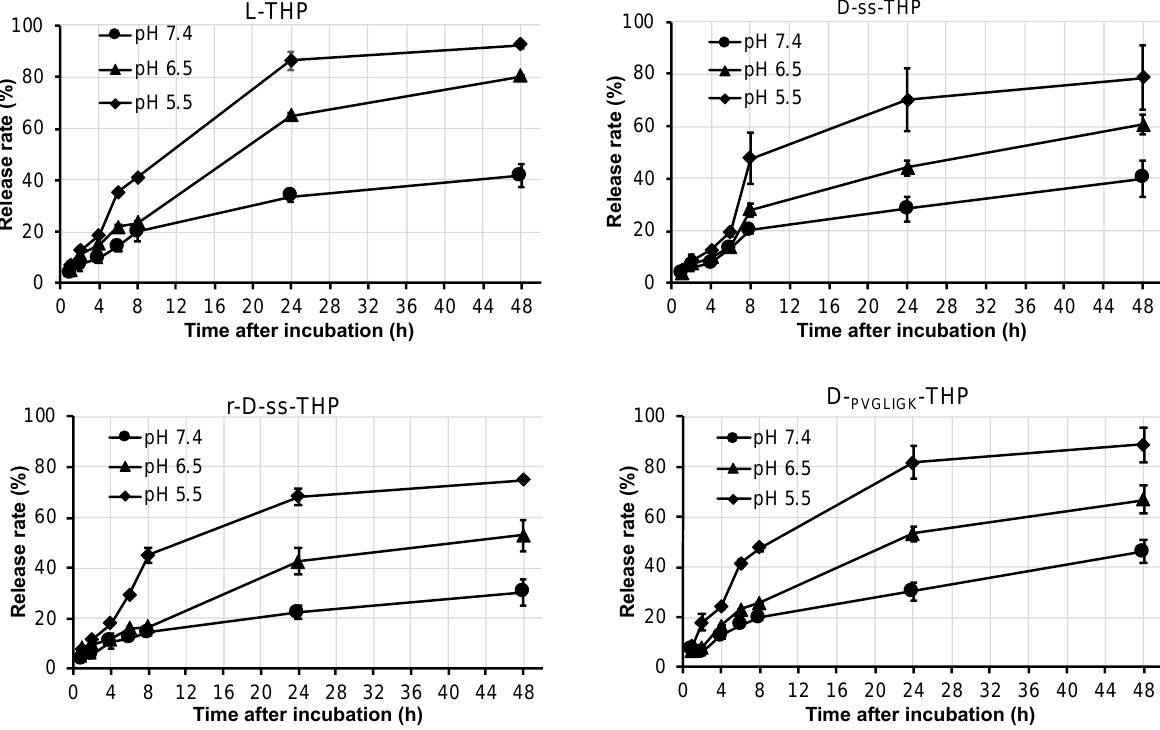
Figure 3. Release of free THP from polymer conjugates L-THP, D-ss-THP, D- PVGLIGK -THP and r-D- ss-THP at different pHs, incubation at 37 °C for the indicated time periods. The amount of released free THP was measured by HPLC. Values are mean ± S.D. ( n = 3).